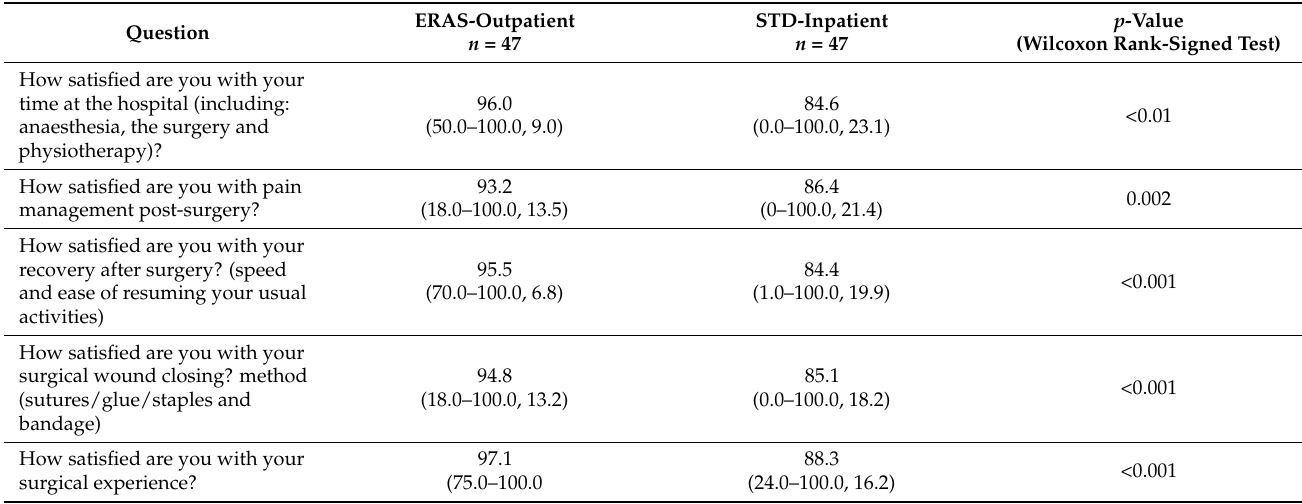
Table 2. Patients’ Satisfaction on a Visual Analog Scale (0–100) [30]. Comparison of ERAS-outpatient group and the control (standard) group illustrating superior patient satisfaction